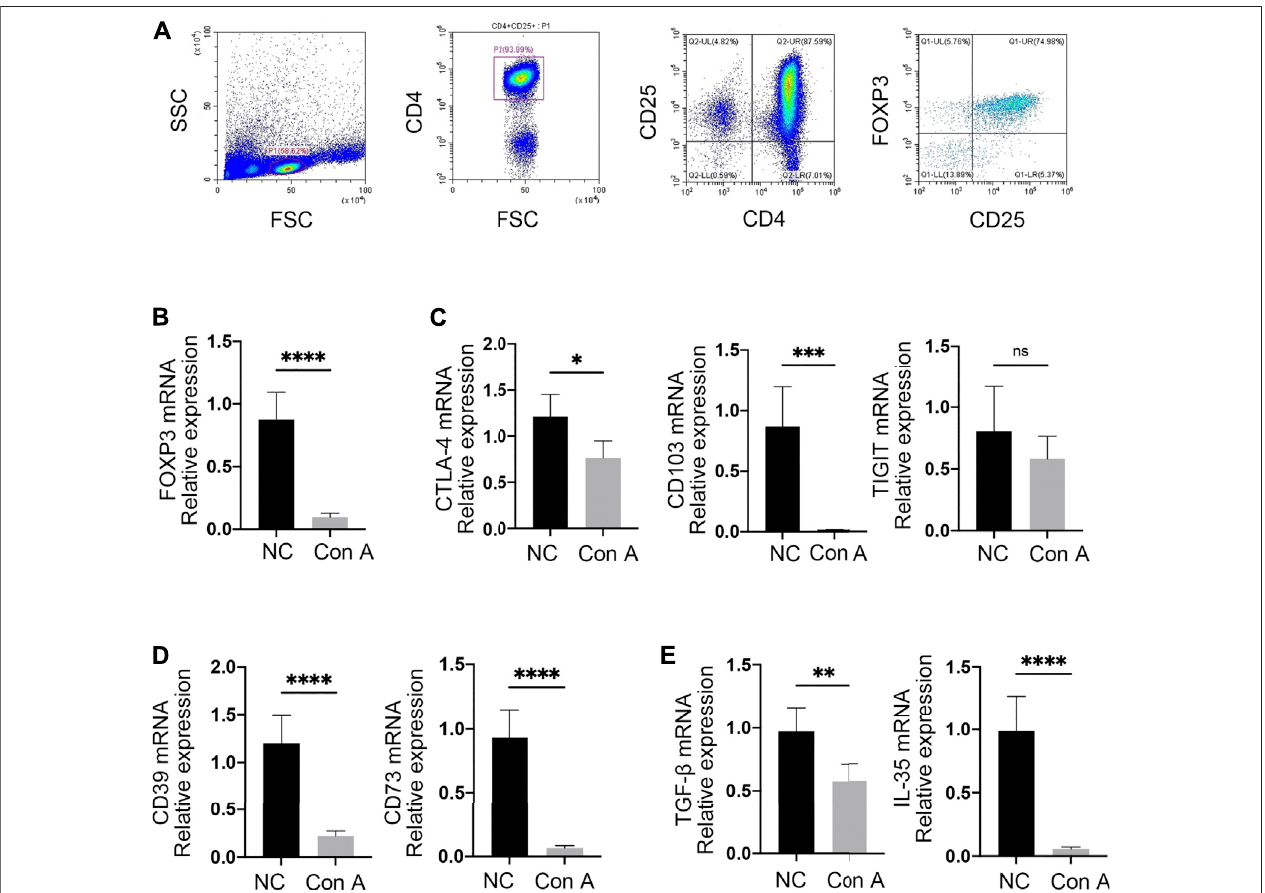
FIGURE 3 | Tregs were functionally impaired in EAH. (A) CD4+ CD25+ Tregs were isolated from mouse spleens by immunomagnetic bead sorting. The purities of CD4+CD25+andCD4+CD25+FOXP3+cellswereassessedbyFCM. (B) TheexpressionofFOXP3wasexaminedbyRT-qPCR. (C) mRNAexpressionlevelsofCTLA- 4, CD103, and TIGIT. (D) mRNA levels of CD39 and CD73 in Tregs from each group. (E) Expression of the anti-in fl ammatory cytokines TGF- β and IL-35. Gene expression was normalized to that of β -actin.